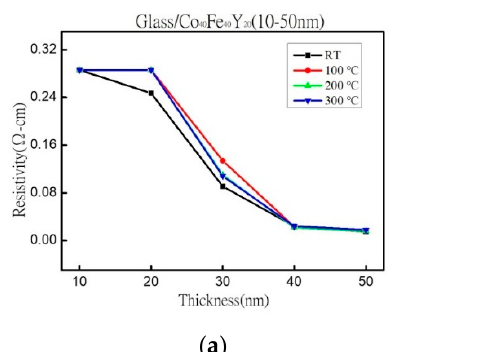
( b ) Figure 6. M-H loop of CoFeY fi lms under four conditions; ( a ) 10 nm and ( b ) 50 nm. 3.3. Electrical Properties The resistivity of various thicknesses and at four conditions is depicted in Figure 7a. Figure 7b displays the sheet resistance for four di ff erent states and various thicknesses. When the fi lm was thicker, the resistivity was smaller, and the amplitude of the resistance was closer to being fl at. Because electron carriers are less constrained in their conduction, the electric resistivity and sheet resistance of thick fi lm thickness and higher annealing temperatures are smaller than those of thinner thicknesses and lower annealing tempera-